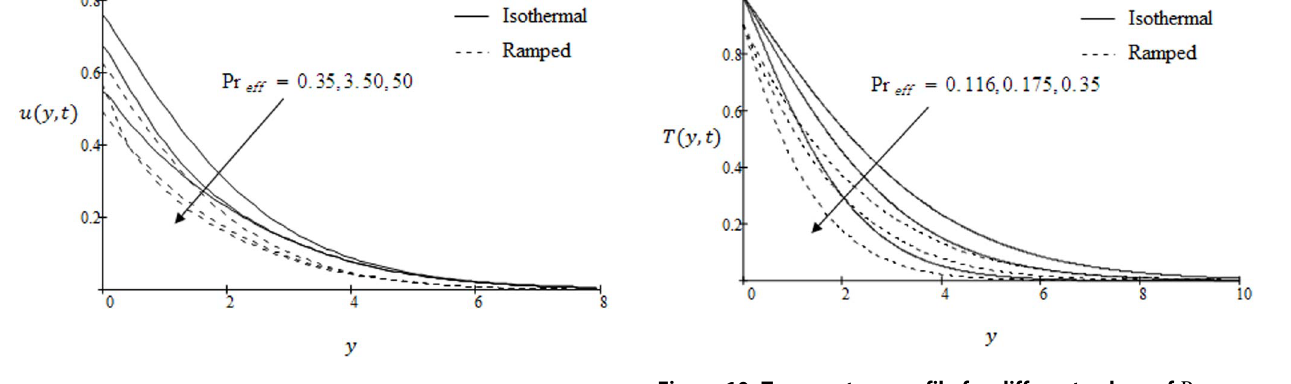
Figure 10. Temperature profile for different values of Pr eff .